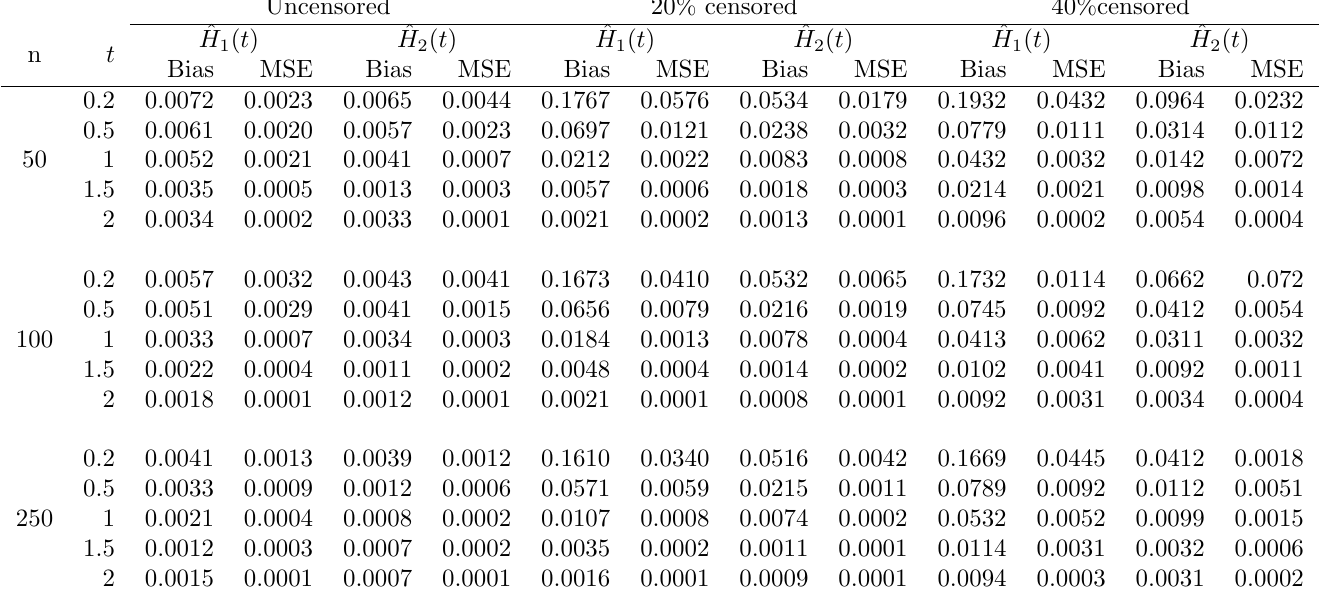
Bias and MSE of the estimates of H 1 ( t ) and H 2 ( t ) for a = 1 . 5 , ϕ = 0 . 2 and λ =